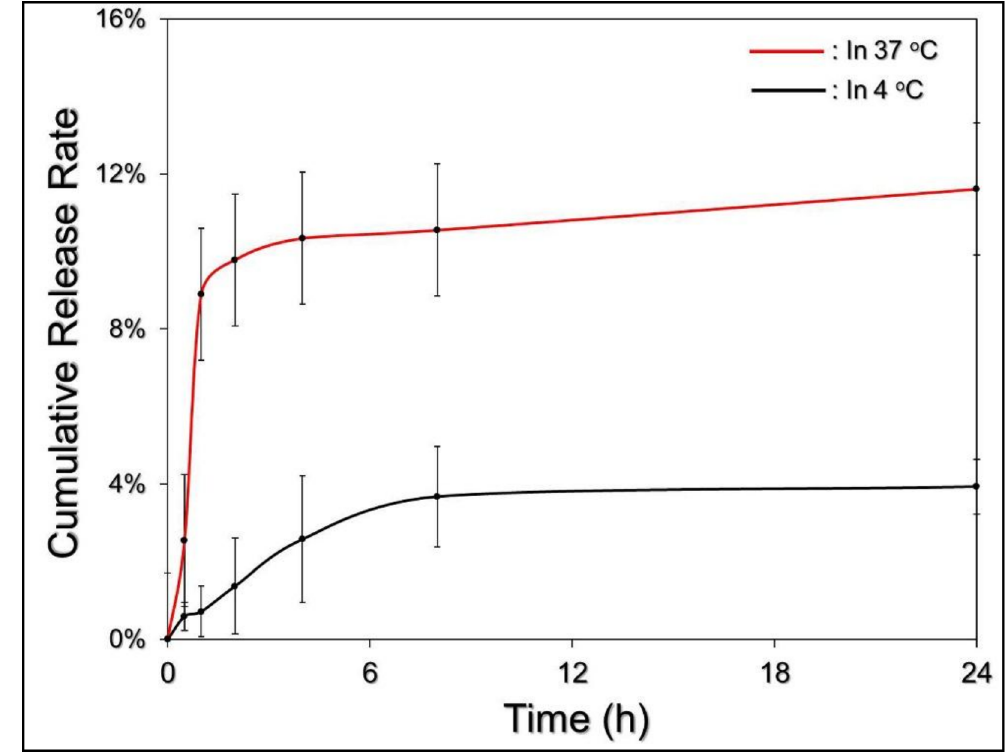
Figure 4. The MMC release profiles of the EIMPDNEs under different temperature